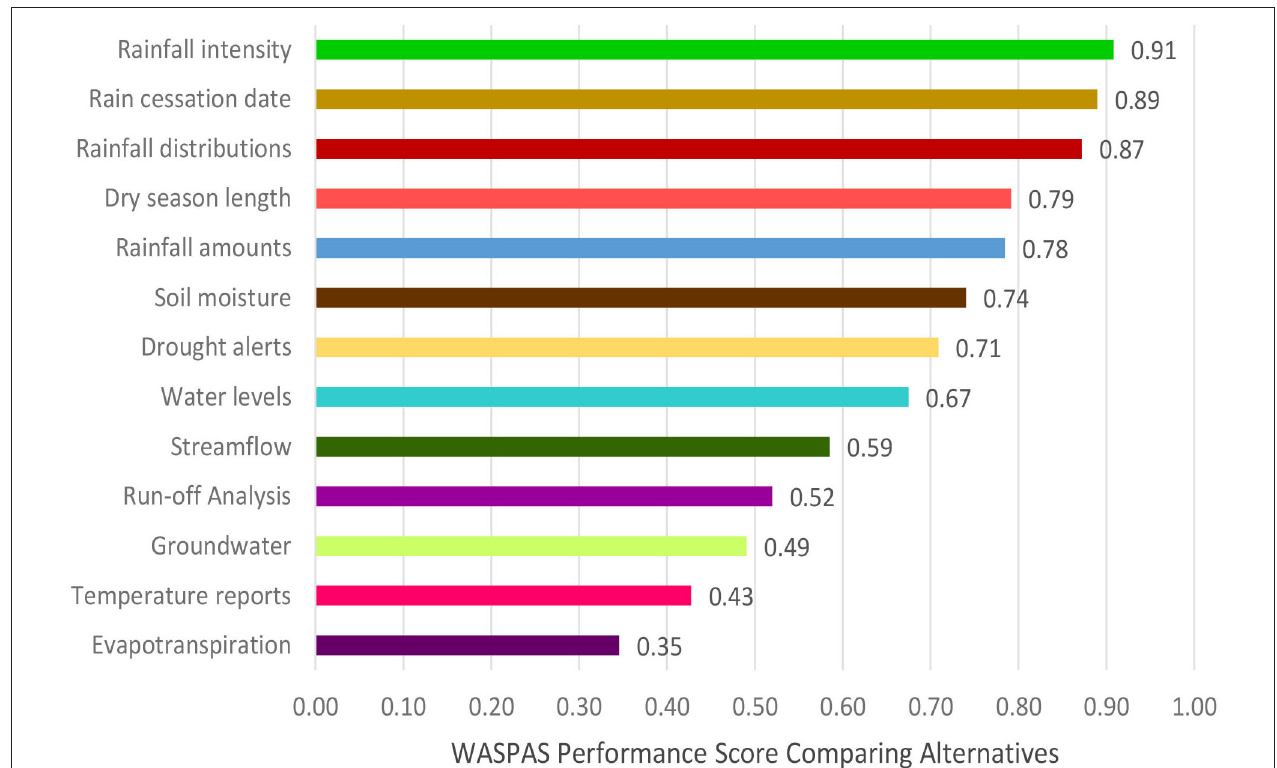
FIGURE 5 | Ranking relative importance of WCI alternatives in water